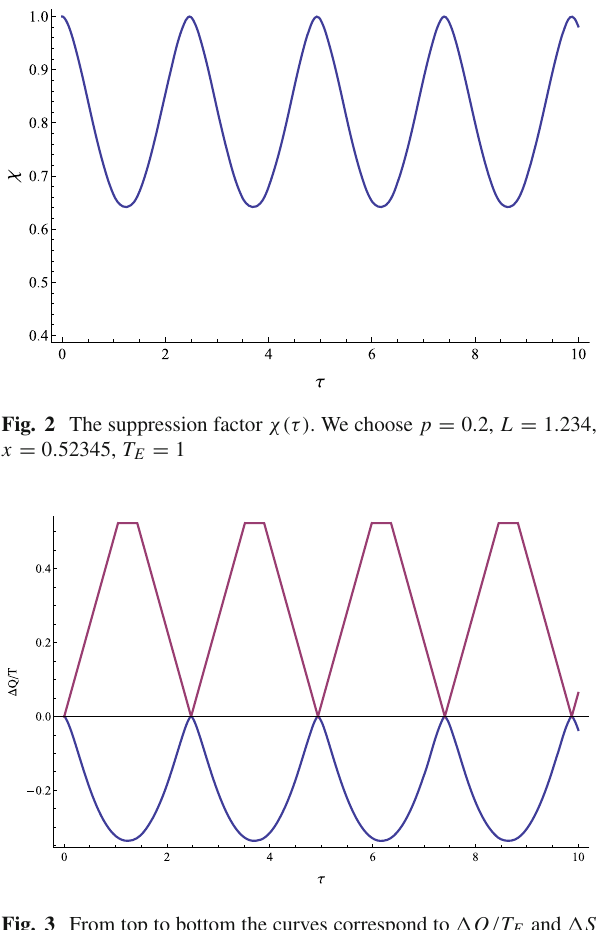
Fig. 3 From top to bottom the curves correspond to (cid:5) Q / T E and (cid:5) S respectively. We choose p = 0 . 2, L = 1 . 234, x = 0 . 52345, T E =